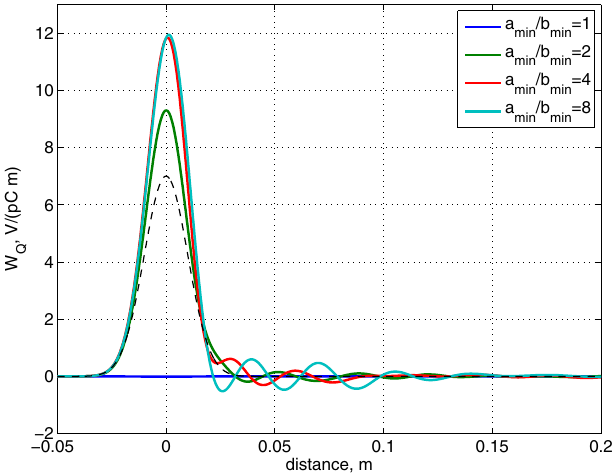
FIG. 3. (Color) Quadrupolar wake potentials (solid line) and beam density (dashed line).